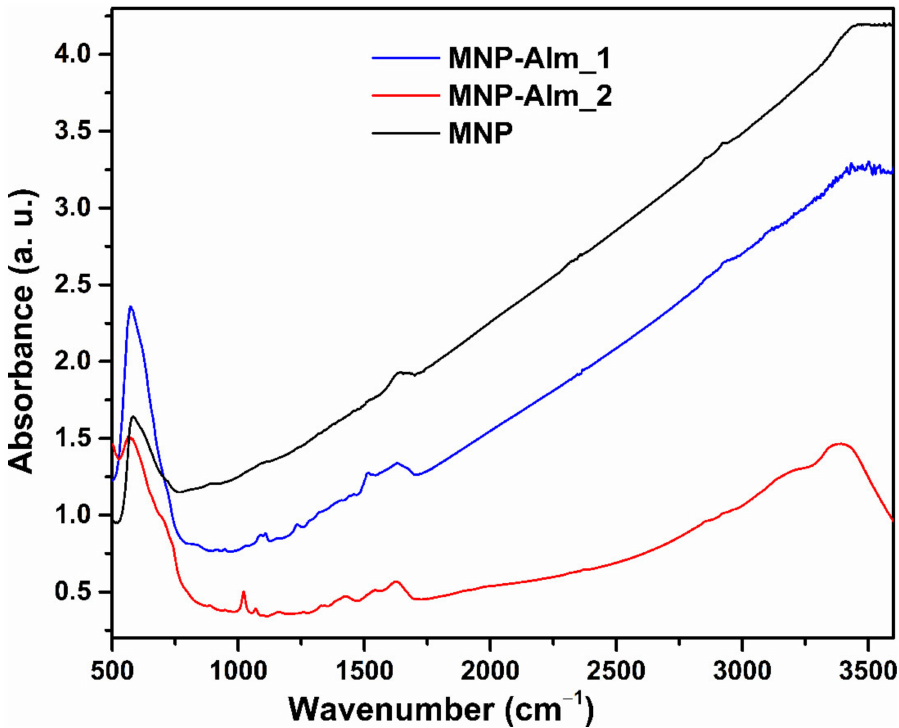
Figure 1. FTIR spectra of uncoated MNP, MNP-AIm_1, and MNP-AIm_2 in KBr pellets.